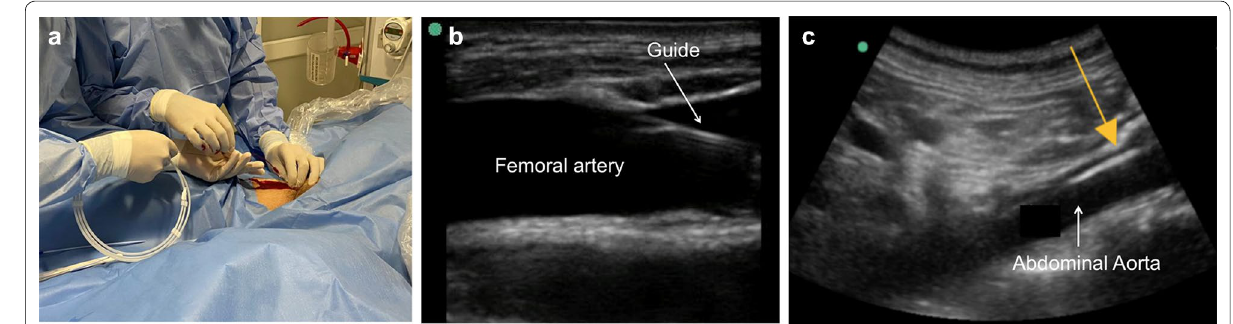
Fig. 3 a Passage of the metal guide through the femoral arterial puncture. b Visualization of the passage of the intravascular guide at the femoral artery with a high-frequency linear transducer. c Verification of the metal guide (yellow arrow) in the abdominal aorta with a low-frequency convex transducer